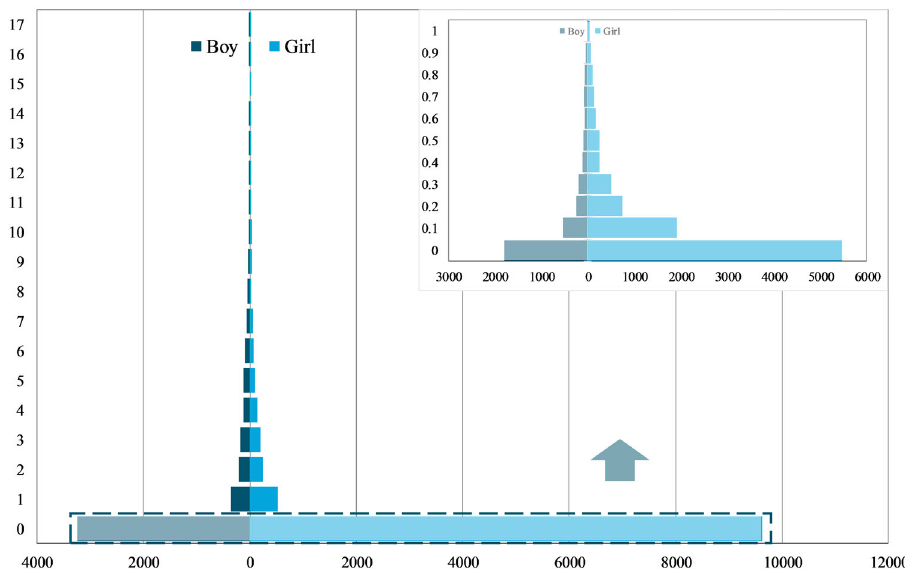
Fig. 1 Gender-age pyramid of informal adoption. The inset shows the results of further subdivision of children under 1-year-old into ten grades.